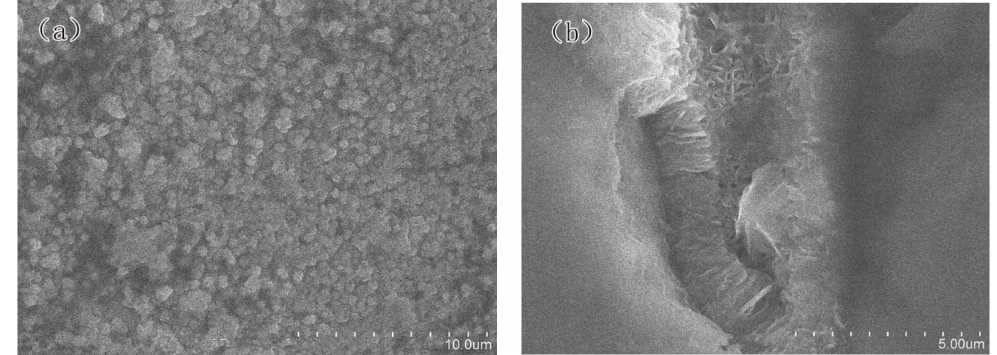
Figure 9. The morphology of corrosion products on the coating surface. ( a ) Low image; ( b ) high